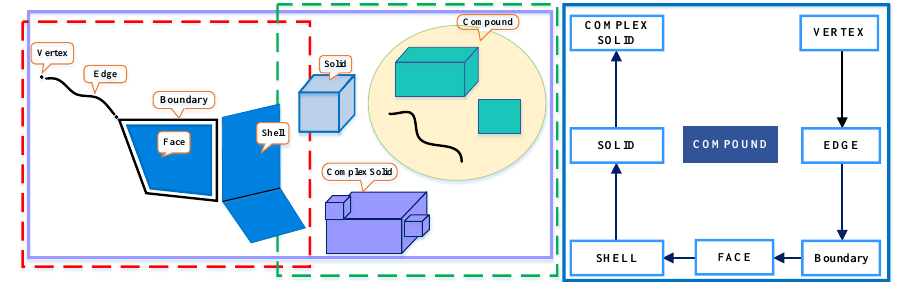
Figure 10. Topology model structure diagram.